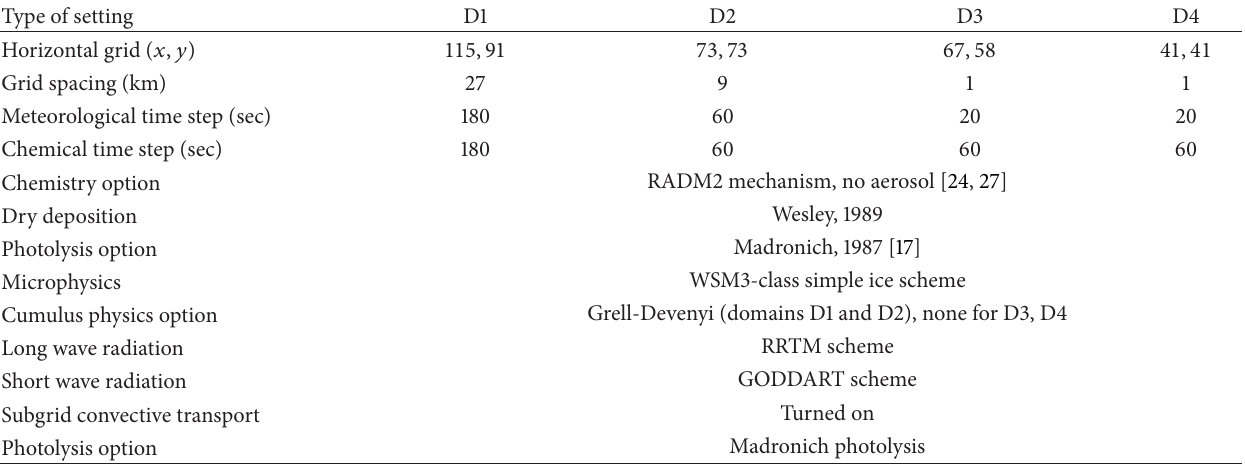
Table 2: Selected domain setting and configuration parameters for WRF-Chem model operation.